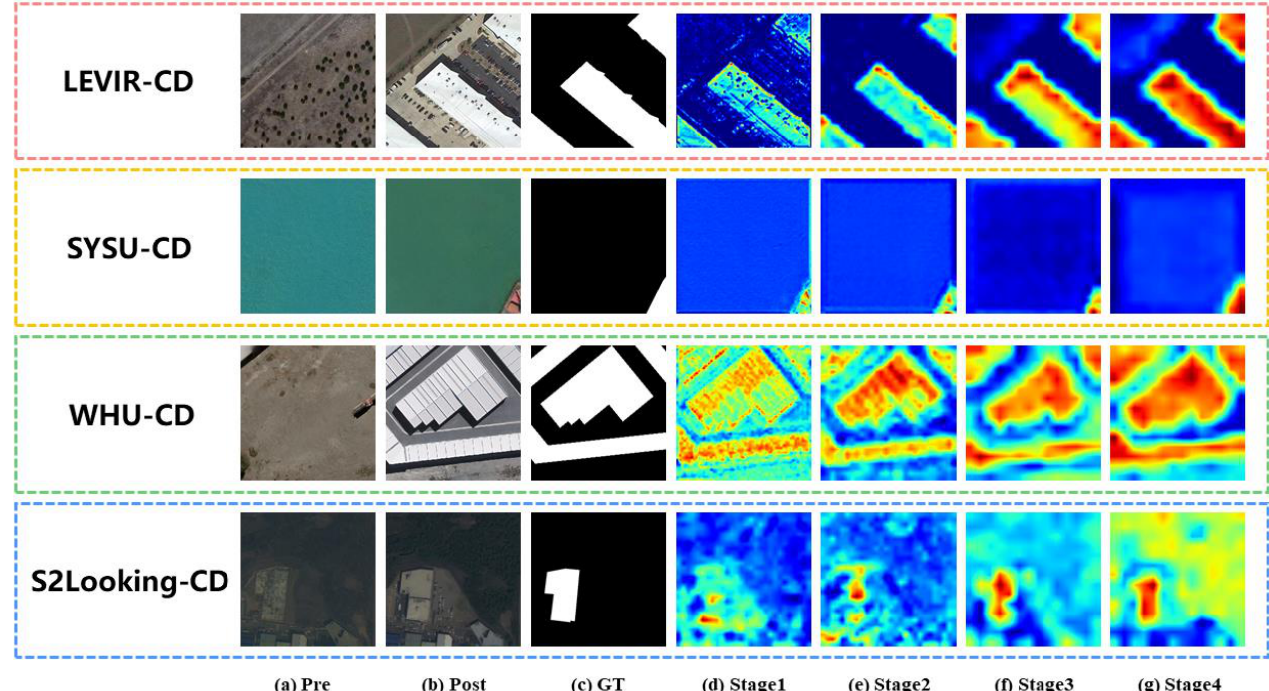
Figure 13. Visual representations of the attention maps generated by the four stages. Note that the color blue indicates a lower level of attention, whereas the color red indicates a higher level of at- tention.